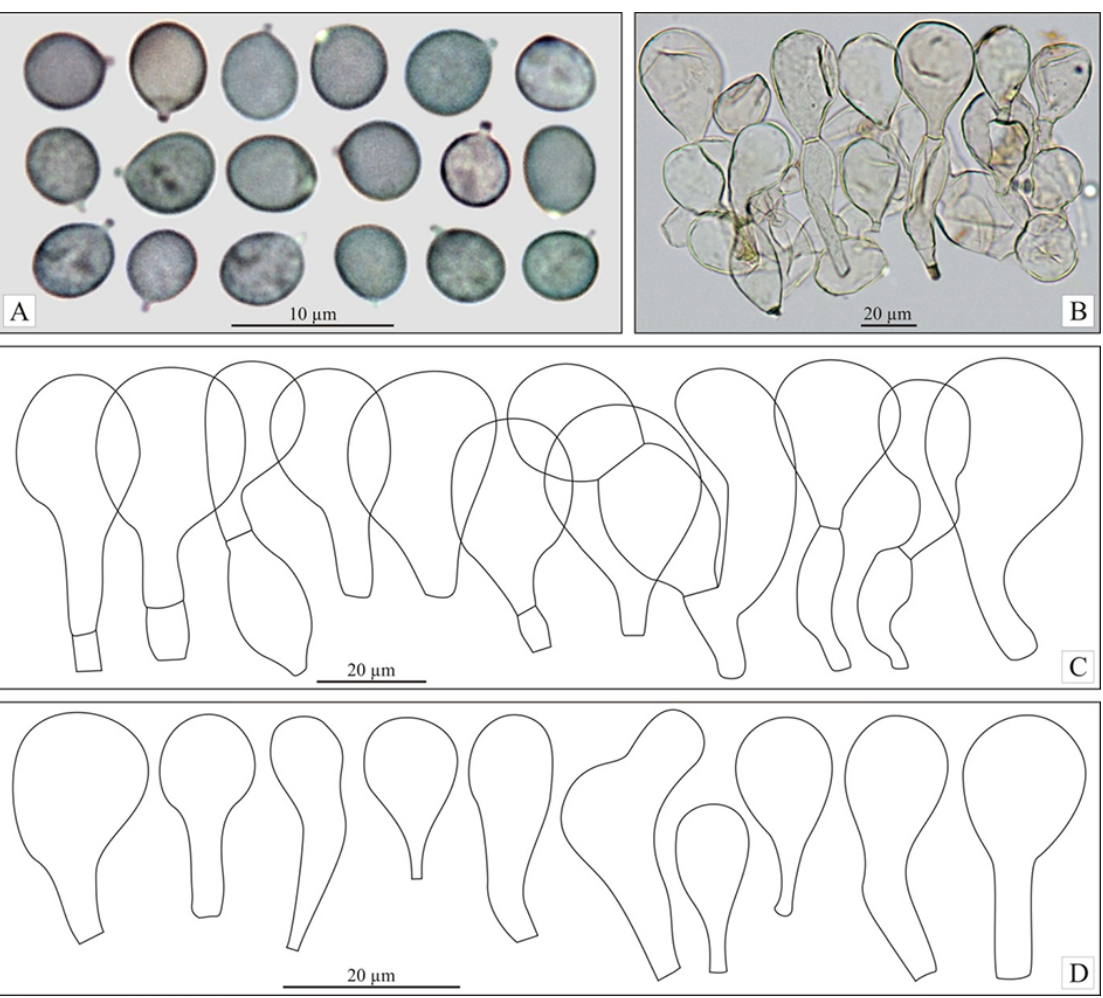
Figure 2 Hodophilus variabilipes Jančovičová, Adamčík & Looney. ( A ) Basidiospores. ( B,C ) Hyphal terminations in pileipellis near the pileus center. ( D ) Marginal cells on lamellar edges. All illustrations photographed and traced from